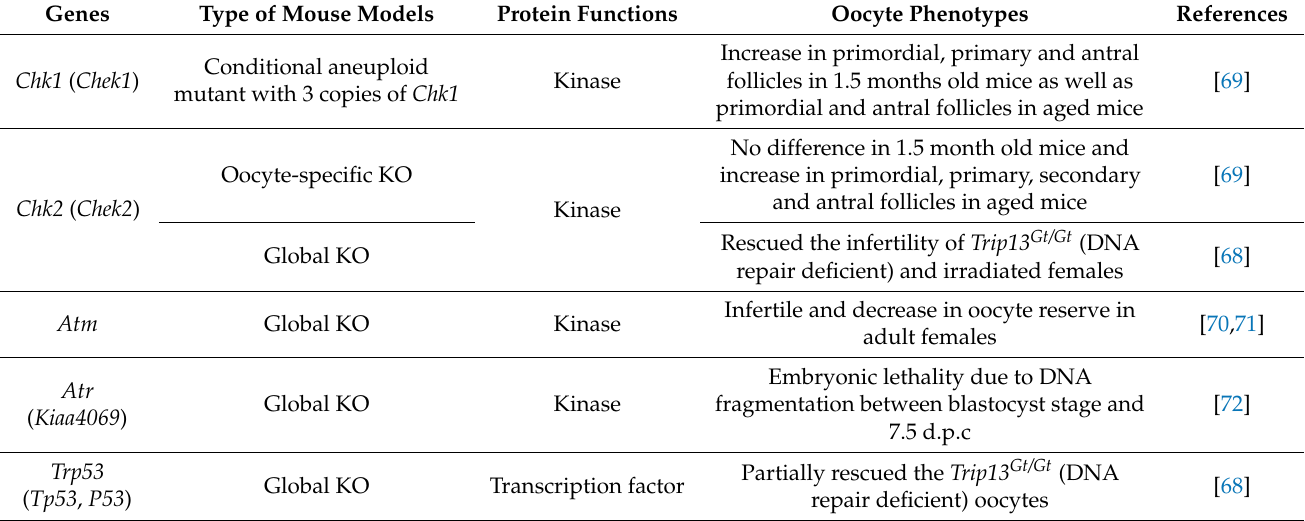
Table 2. Gene knockout mice related to the DNA damage